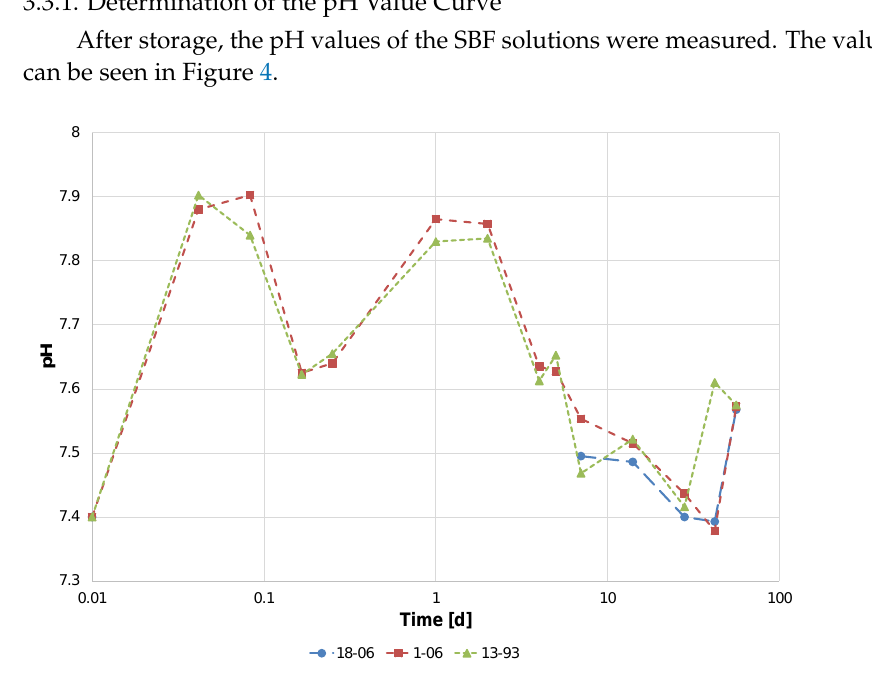
Figure 4. Changes of the pH value of the SBF solution at